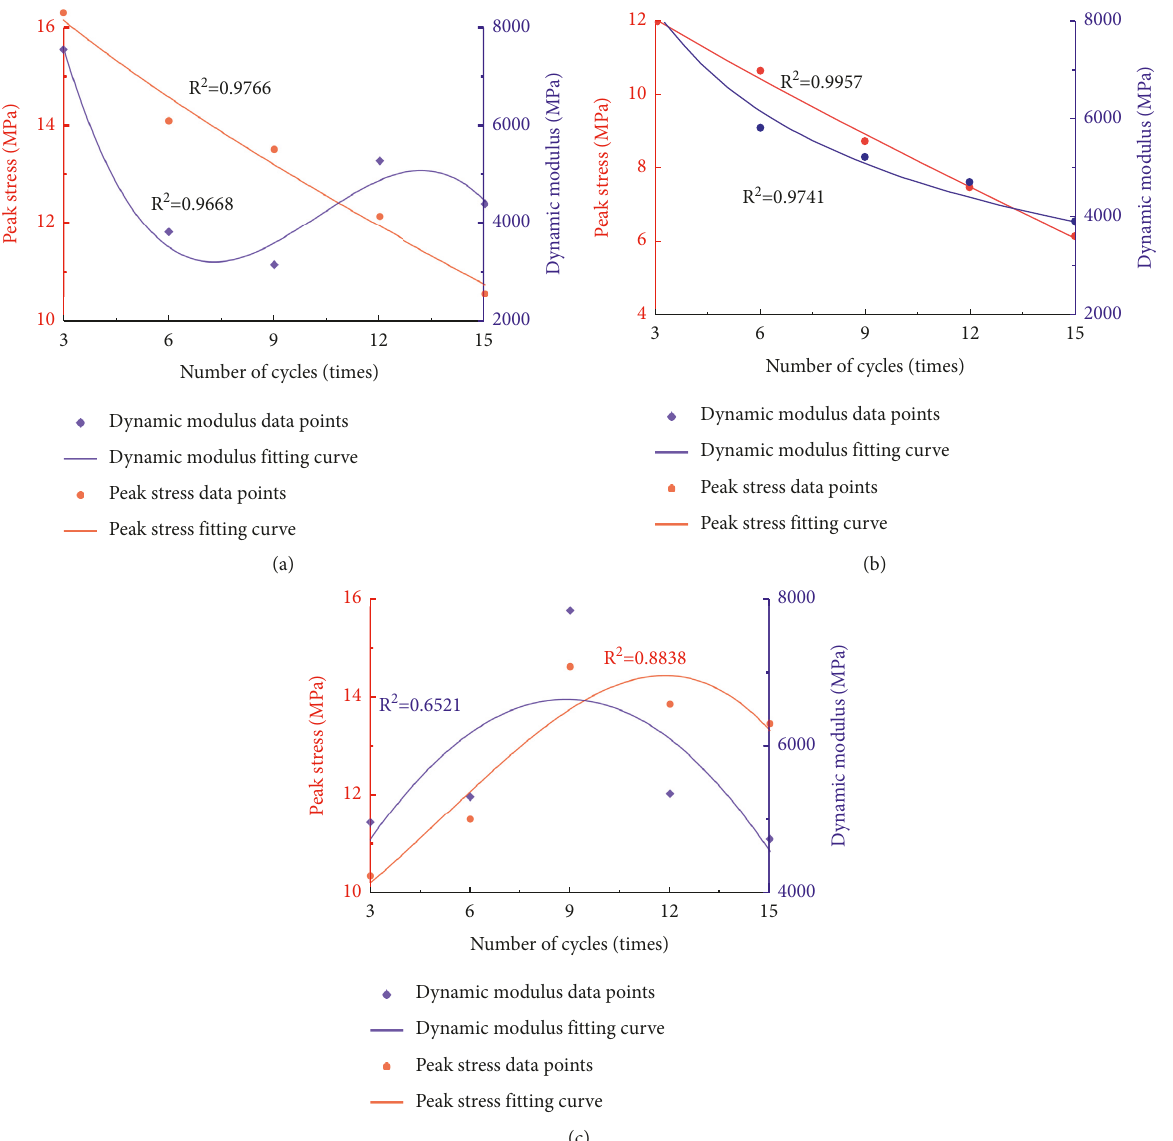
Figure 5: Fitting curves of peak stress and dynamic modulus of semirigid base material versus the number of cycles. (a) Fitting curve at